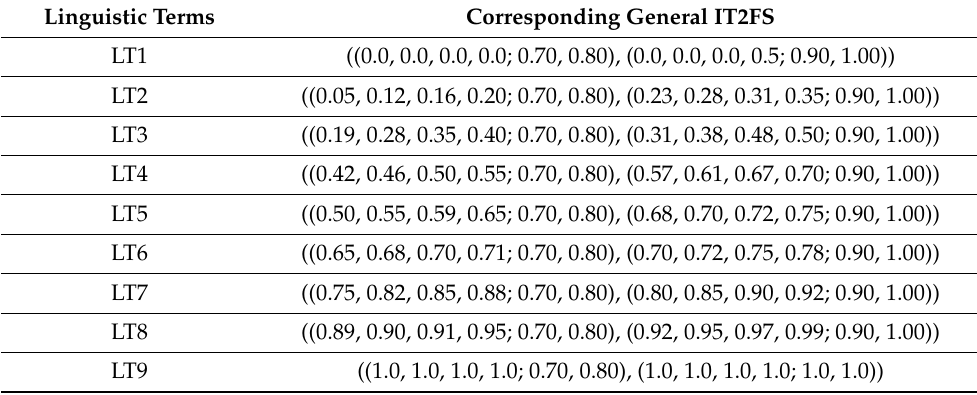
Table 2. Linguistic terms in the form of general interval type-2 fuzzy sets. Linguistic Terms